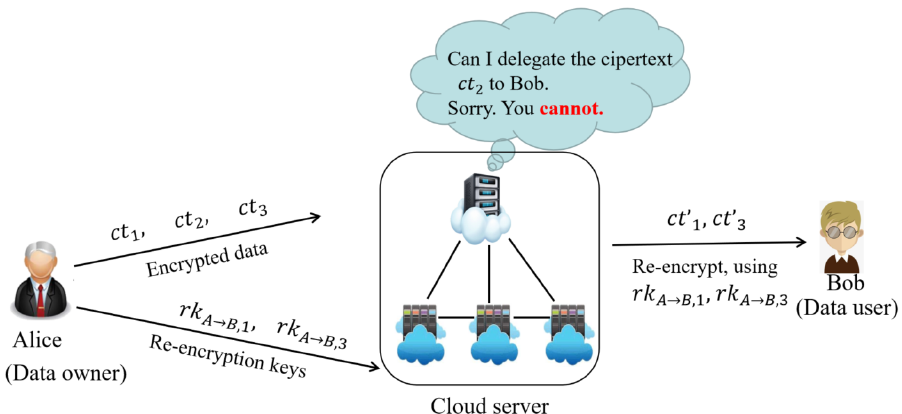
Figure 1. UCPRE in a cloud data sharing